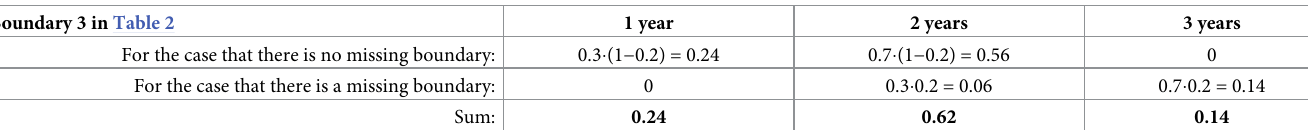
Table 3. Boundary 3 in Table 2.